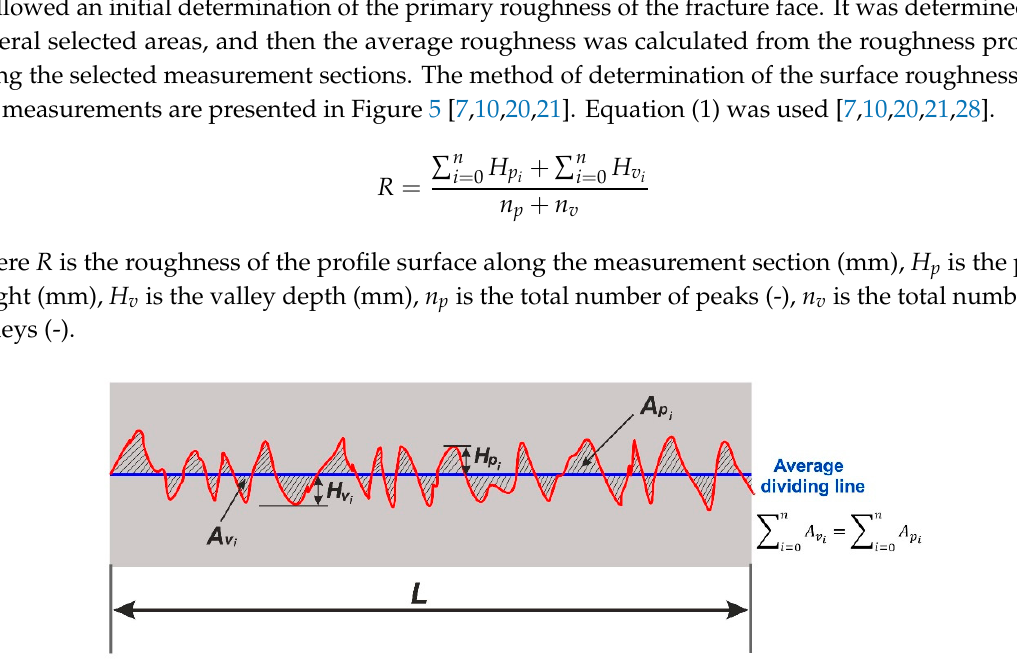
Figure 4. Materials used for testing: ( a ) Shale rock; ( b ) Proppant.